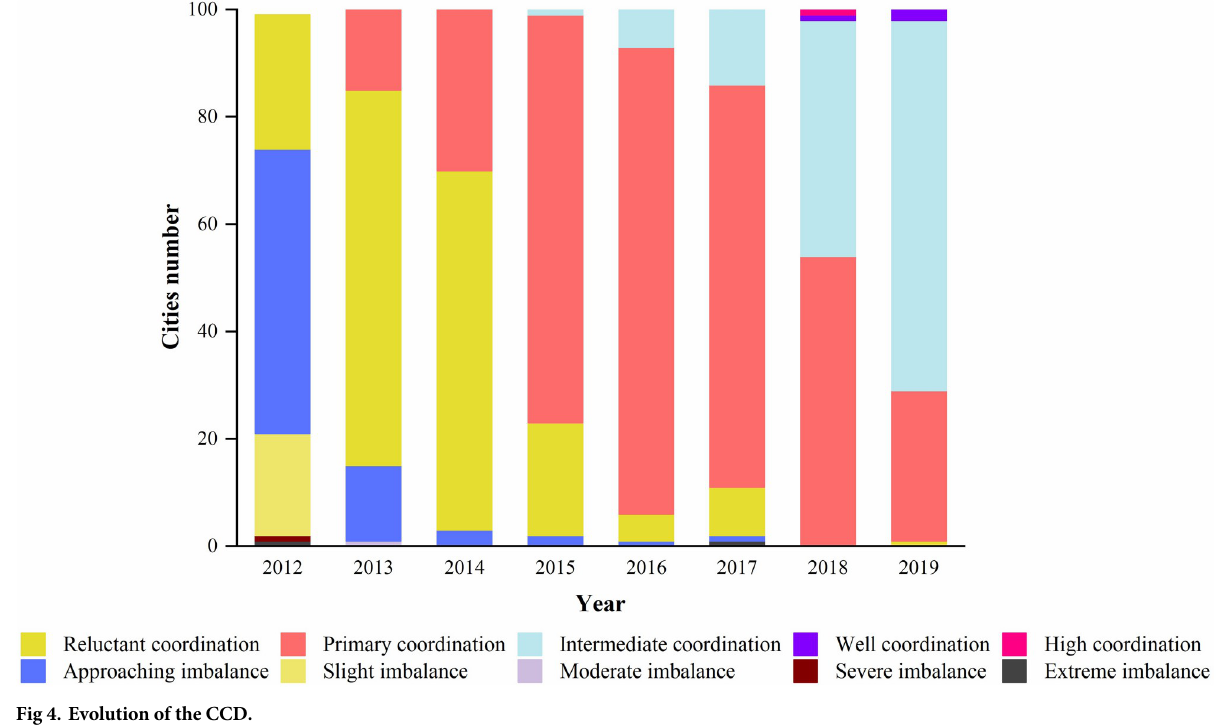
Fig 4. Evolution of the CCD.